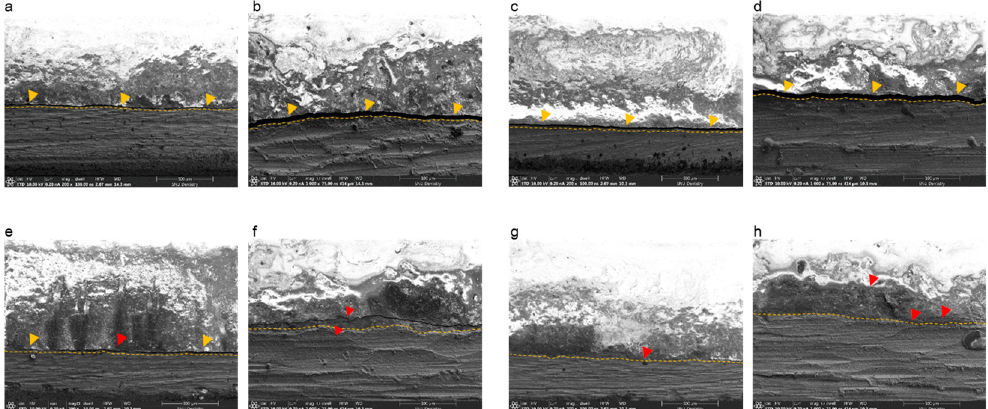
Figure 5. SEM images of specimens after the three-point bending test and before manual detachment of the ceramic portion. ( a ) Casted specimen, magnification 200×; ( b ) casted specimen, magnification 1000×; ( c ) selective laser melting (SLM)-fabricated specimen without bonding agents, magnification 200×; ( d ) SLM-fabricated specimen without bonding agents, magnification 1000×; ( e ) SLM-fabricated specimen with bonding agent A, magnification 200×; ( f ) SLM-fabricated specimen with bonding agent A, magnification 1000×; ( g ) SLM-fabricated specimen with bonding agent B, magnification 200×; ( h ) SLM-fabricated specimen with bonding agent B, magnification 1000×. Dotted lines represent the surface of the Co-Cr alloy. Yellow triangles indicate crack propagation and the large gap between the ceramic and metal layers. Red triangles indicate incomplete crack propagation.